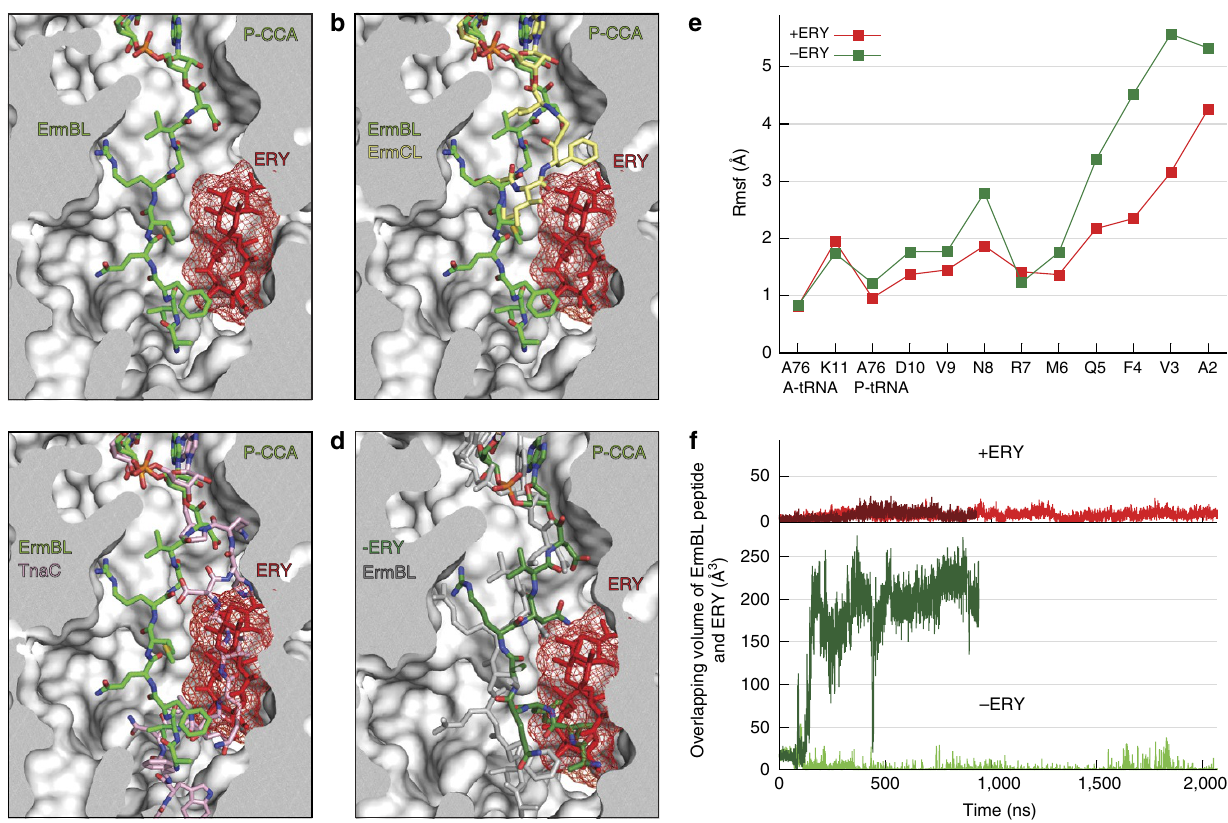
Figure 2 | Path of ErmBLwithin the ribosomal tunnel. ( a , b ) Path of ( a ) ErmBL (green) and ( b ) ErmCL (yellow) within the ribosomal tunnel with bound ERY (red mesh). ( c ) Path of TnaC (pink) compared with the path of ErmBL (green) within the ribosomal tunnel with superimposed ERY (red mesh). ( d ) Path of ErmBL after 700-ns simulation time in absence of ERY (green) compared with ErmBL as seen in the cryo-EM structure (grey). ( e ) Fluctuations of the tRNA A76 nucleotides and ErmBL residues in presence (red) and absence (green) of ERYobtained from the simulations. ( f ) Overlap between the ErmBL peptide and the volume occupied by ERY in the course of the